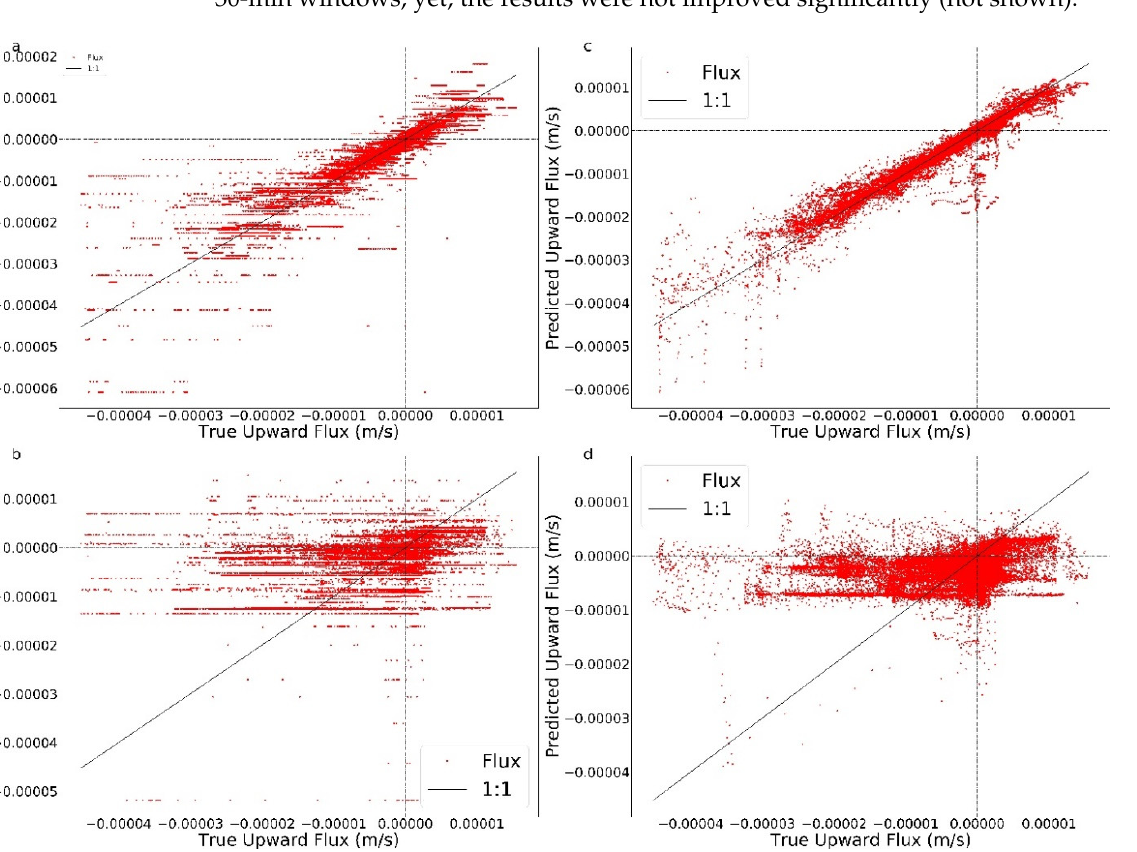
Figure 7. Testing results using temperature sensors only, which are located at 0.015, 0.105, and 0.195 m. ( a ) Noise-free data using RT. ( b ) Noise-free data using GB. ( c ) SNR = 100 noisy data using RT. ( d ) SNR = 100 noisy data using GB.